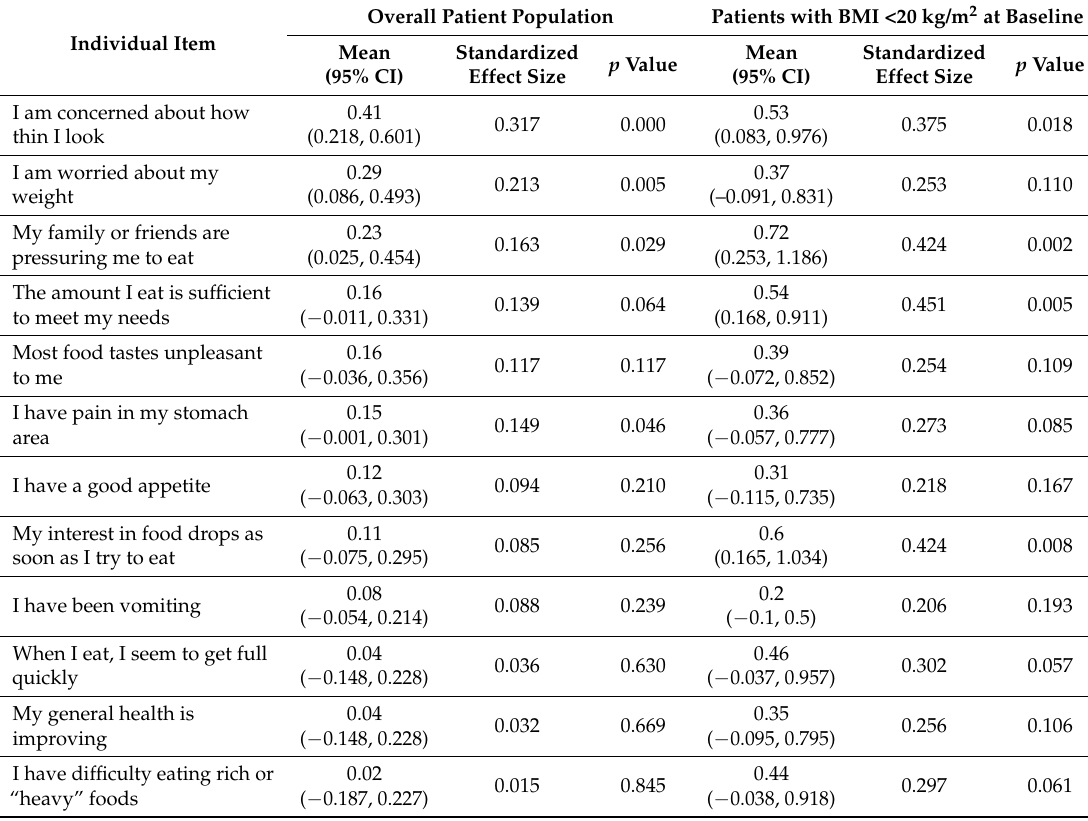
Table 3. Anamorelin treatment effect size on the 12 individual items of the FAACT A/CS